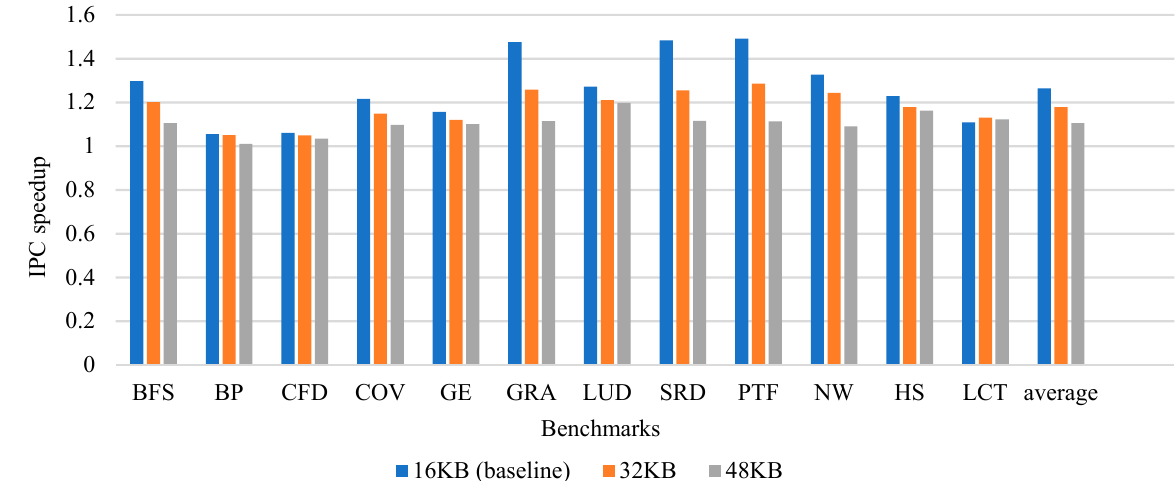
Figure 8. IPC speedup over different cache capacity.